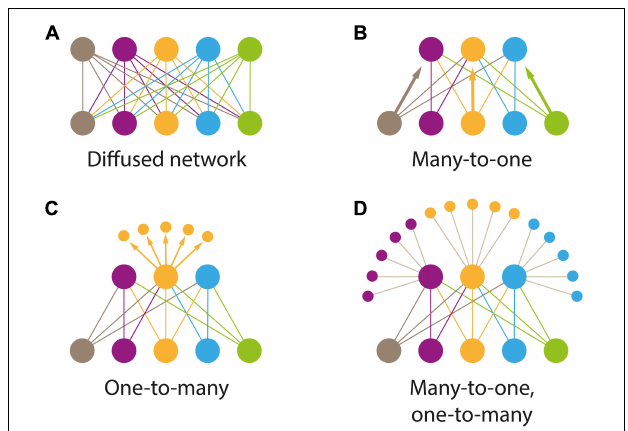
FIGURE 3 | Types of information flow patterns that were specialized during brain evolution and in different clades. A diagram showing the common blocks shared among various animals and used for the regulation of different cognitive tasks. Shigeno (2017) has proposed that the neuronal networks configuring the brains (Nervous Systems) of all animals can be classified into four basic types. (A) “Diffused type.” Information processing occurs in simple elements called nodes (i.e., Cnidaria); (B) “Many to one” type. Present in the so-called primitive brains, a diffuse set of neuronal processes converge into an anterior structure (brain), located in the vicinity of sensory organs (i.e., Acoelomorpha); (C) “One to many” type. The connectivity pattern is organized in one centrally located processing unit (brain), and then processed in “many” small, higher order interneurons, generally called globuli in protostomes (i.e., polyclad flatworms or Annelida). In some clades, there is a feedback loop between the primary and other higher order centers. (D) “Many to one, one to many” type. They are organized in a hierarchical fashion (i.e., cortical to subcortical; with subcortical centers projecting back to cortical centers). This is the type of organization seen in mammalian or cephalopod brains. It is assumed that artificial neural networks use similar construction arrangements. Adapted from Shigeno